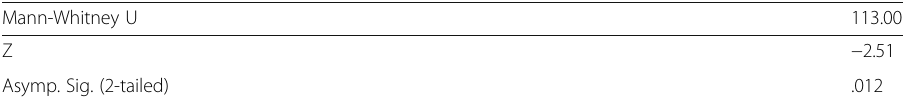
Table 9 Test statistics for the feedback giver group and feedback receiver group in the picture description